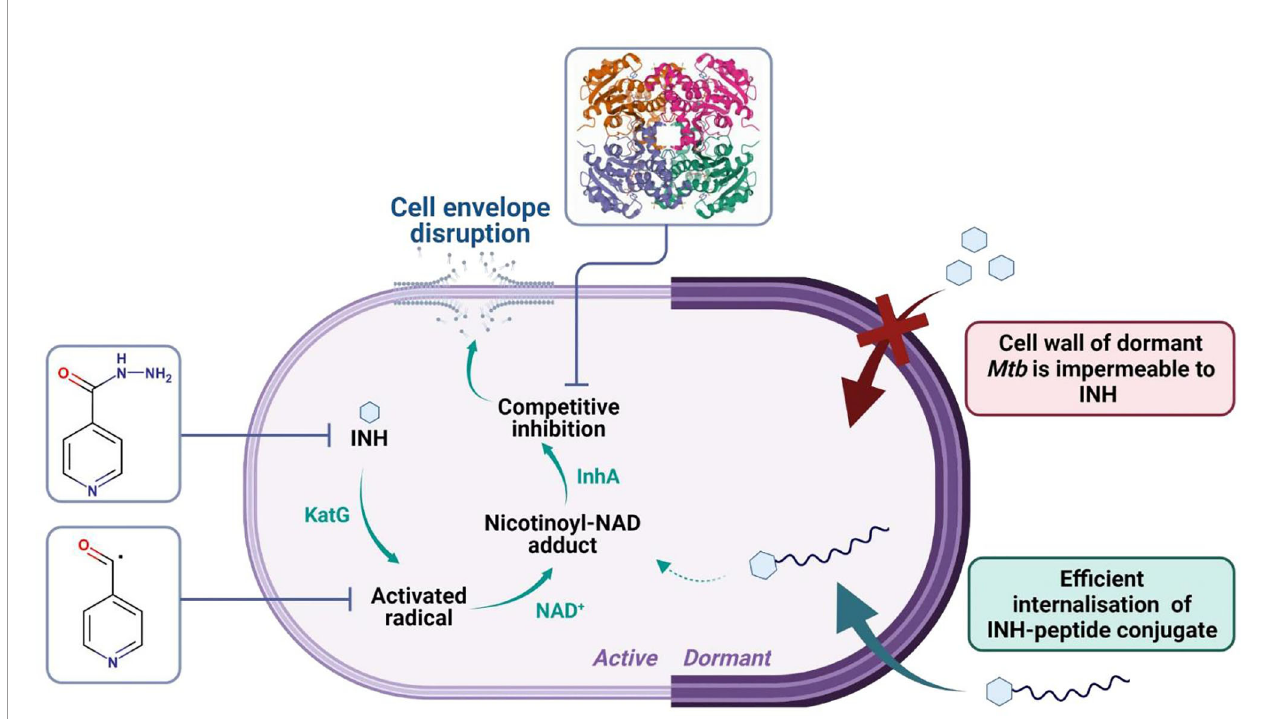
FIGURE 11 | Cell wall alteration of dormant Mtb inhibits the internalization and antitubercular activity of INH. Isoniazid penetrates the cell wall of actively growing Mtb . The prodrug is activated by the mycobacterial KatG enzyme, which converts INH to a nicotinoyl radical. The activated radical forms a covalent adduct with NAD + or NADP + . The INH-NAD adduct acts as a tight-binding competitive inhibitor of InhA (PDB ID: 4TRN). InhA (enoyl acyl carrier protein reductase) catalyzes a fatty acid elongation cycle in the type II fatty acid synthase (FAS-II) system, which is involved in the biosynthesis of mycolic acid. The inhibition of the synthesis of this essential cell wall component leads to membrane disruption and, as a consequence, death of the bacterium. INH is highly active against replicating but not against dormant or near-dormant bacteria. During dormancy, Mtb is shielded by an extremely robust cell wall, which is impermeable to INH and most drugs. With the help of peptide conjugation, ef fi cient cell penetration of dormant, intracellular Mtb was